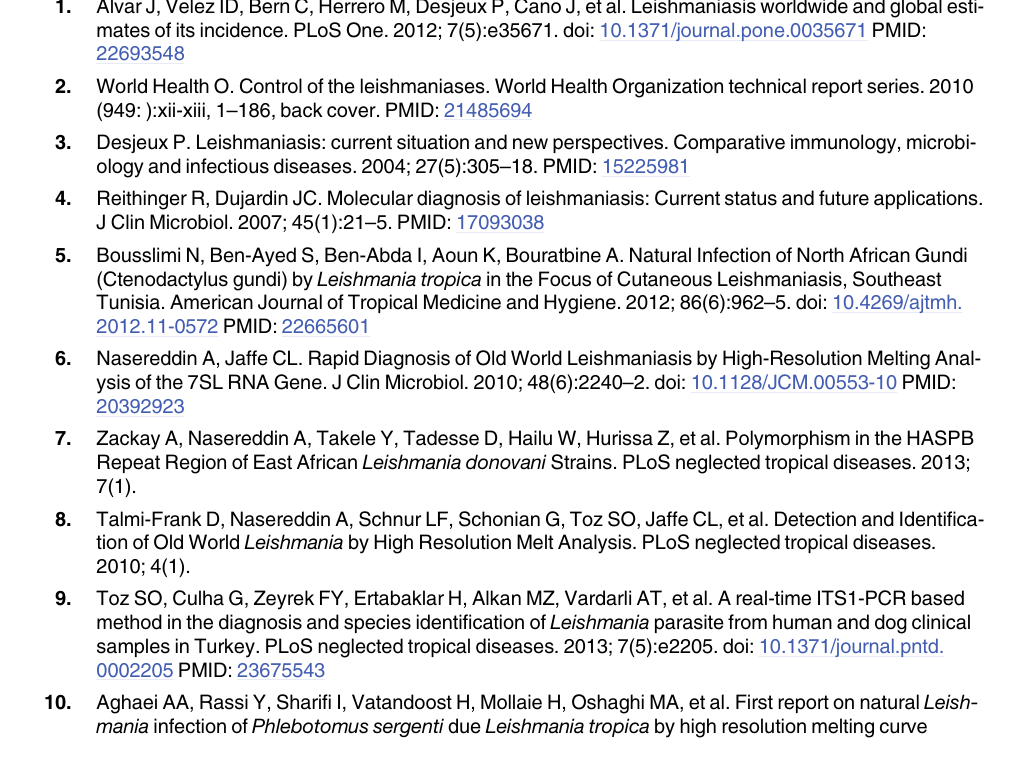
S4 Fig. HRM plots of hsp70 amplicon 1 from Trypanosoma . Representative melting profiles of hsp70 amplicon 1 obtained from the genomic DNA of T . cruzi and T . brucei . (A): Normal- ized melting curves; (B): normalized difference curves and (C): dispersion graph of individual plots from T . cruzi ( Tc ) and T . brucei ( Tb ) compared to L . (L . ) tropica ( Lt ). (TIFF) S1 Table. Polymorphisms detection by in silico analysis of Leishmania hsp70 sequences. The hsp70 regions compassing amplicon 1 or amplicon 2 were retrieved from GenBank Data- base [32] using the sentence “ heat shock protein 70 kDa ” as descriptor words in “ search ” field. The obtained sequences were formatted as FASTA files and aligned on BioEdit Sequence Alignment Editor v.7.1.8 [33]. The identity indexes were obtained by pairwise alignments on BioEdit software. Only sequences encompassing the whole amplicon were analyzed. Theoreti- cal melting temperatures of hypothetic amplicons were calculated using OligoCalc oligonucleo- tide properties on-line calculator